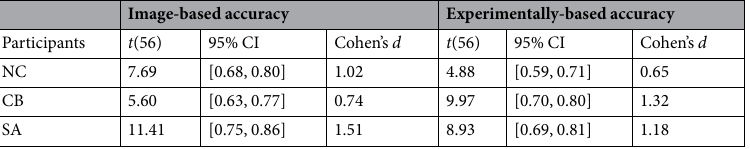
Table 1. Evaluation of perception-based reconstructions across stimuli. Note: CI = confidence interval.